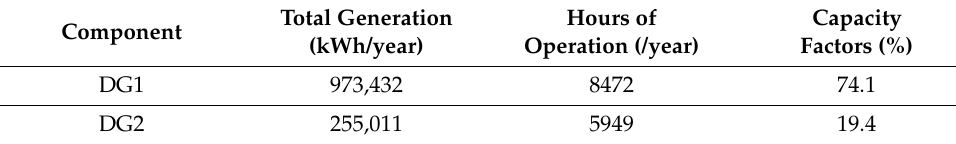
Table 7. Generation and capacity factor of diesel generators (unit: